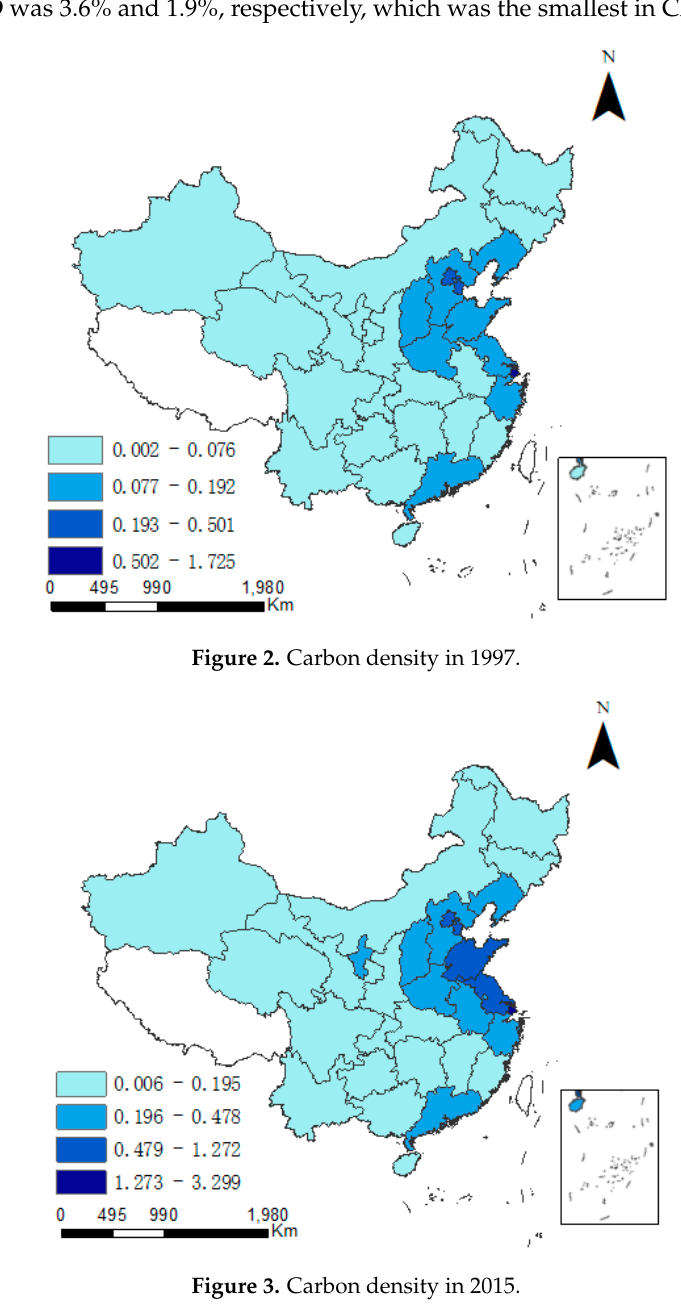
Figure 3. Carbon density in 2015.